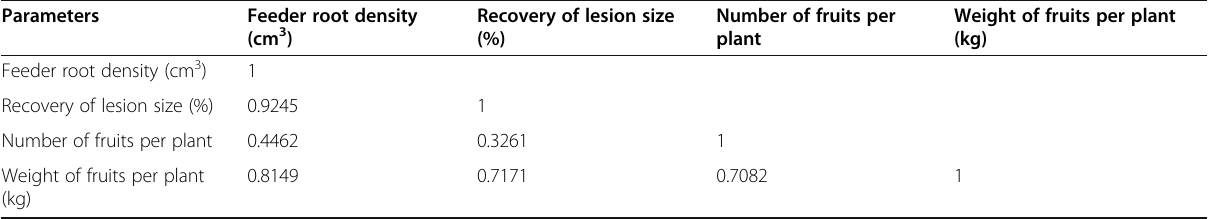
Table 6 Correlations (Pearson) between different parameters under field